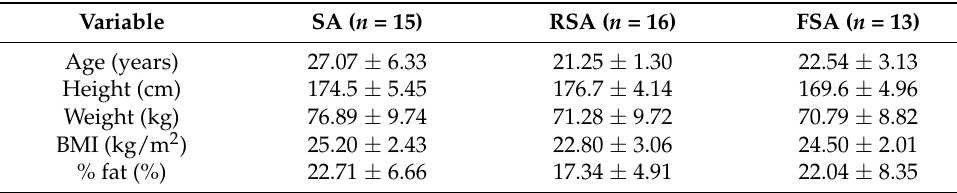
Table 1. The characteristic of the